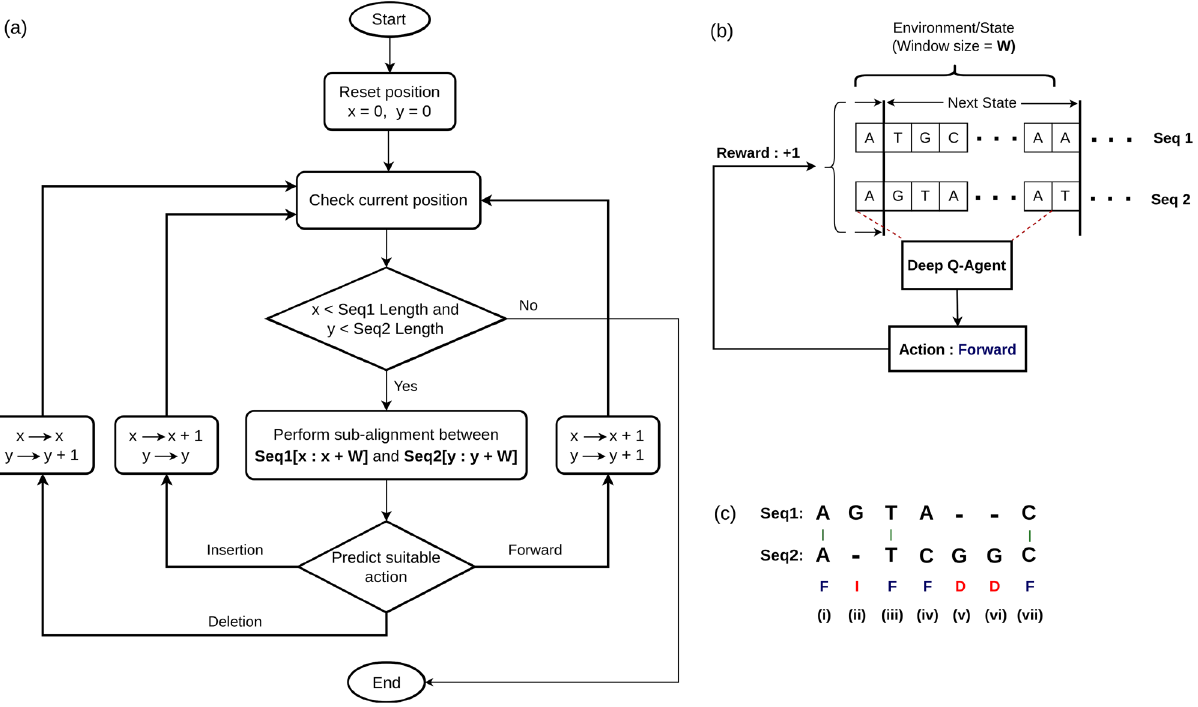
Figure 1. ( a ) Overview of EdgeAlign algorithm, operated on two sequences (Seq1 and Seq2). x and y denote the current nucleotide indices for the first and second sequence, respectively, and W denotes the size of